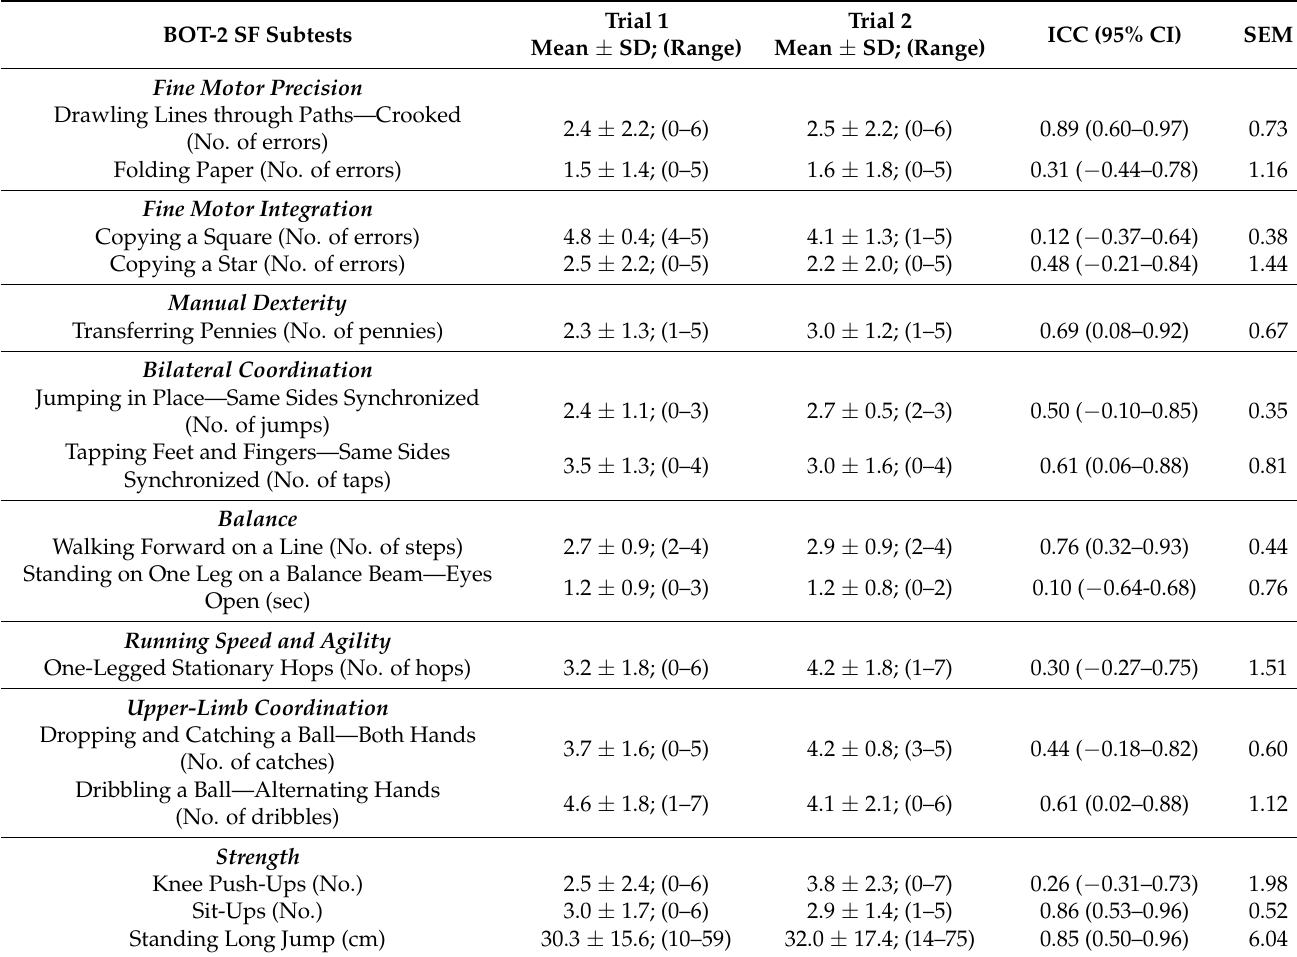
Table 3. BOT-2 SF subtest scores, intraclass correlations (95% CI), and standard error of the measurement